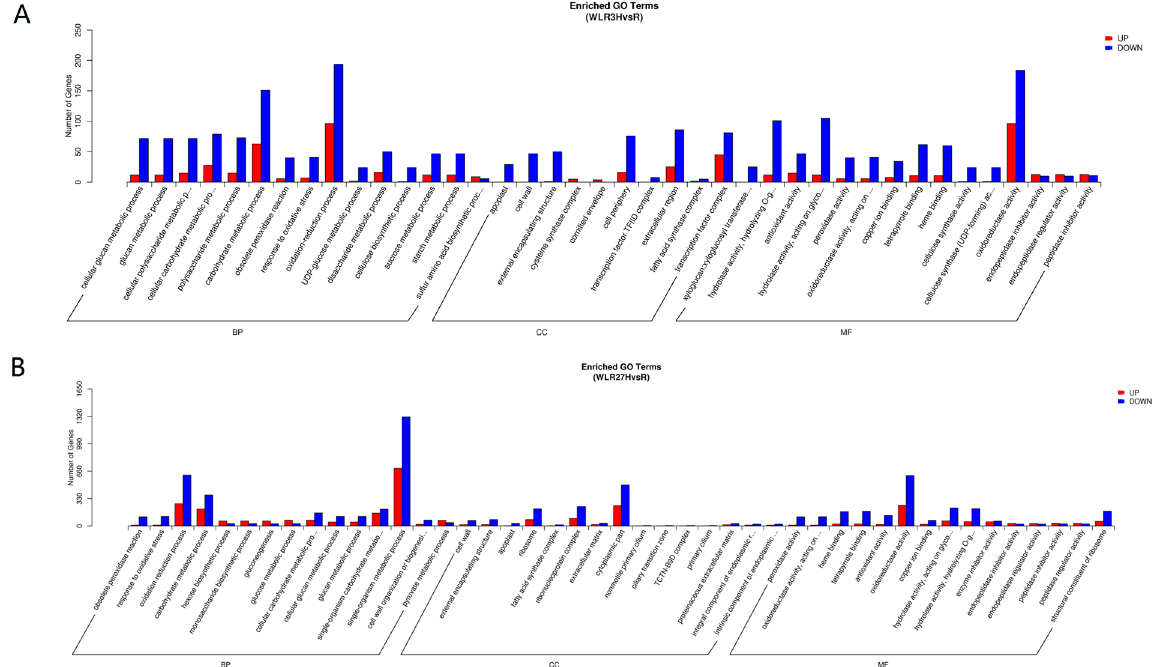
Figure 3. GO functional classification of the control and waterlogging treated plantlets. ( A ) comparison between 3 h treatment and CK; ( B ) comparison between 27 h treatment and